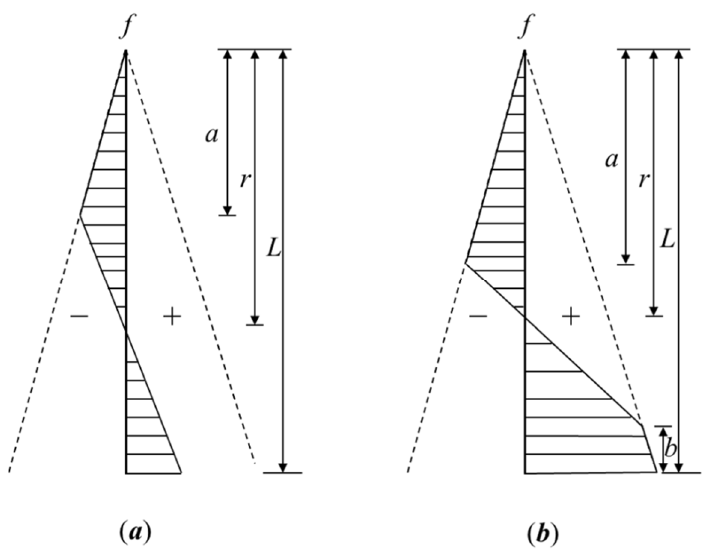
Figure 3. Distribution of skin friction of a single pile: ( a ) Case 1; ( b ) Case 2. Case 1: When the relative settlement of pile soil at pile bottom is small, PSF does not reach the plastic stage and the resistance of pile bottom soil is N . The settlement of the surrounding soil is larger than that of the pile shaft within the depth range of r . The NSF occurs in this section and reaches the ultimate value within the depth range of a , as shown in Figure 3a.